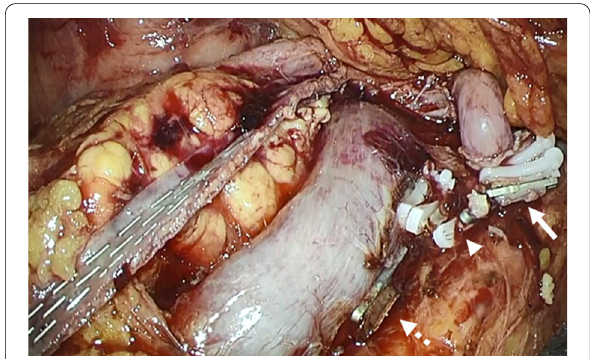
Fig. 2 Intraoperative findings around the stump of the pancreas. The stump of the pancreas appeared to be well enclosed with a linear stapler. The stump of the splenic artery (arrow), splenic vein (arrowhead), and inferior mesenteric vein (dotted